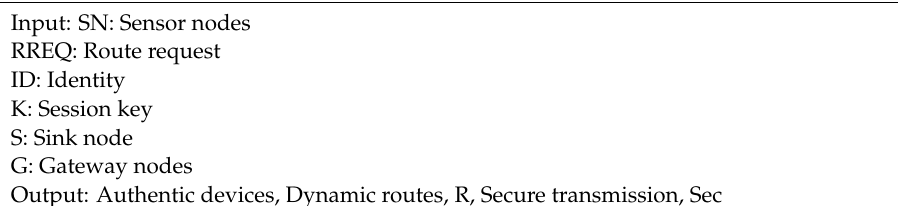
Algorithm 1: Multi-criteria learning algorithm with secured